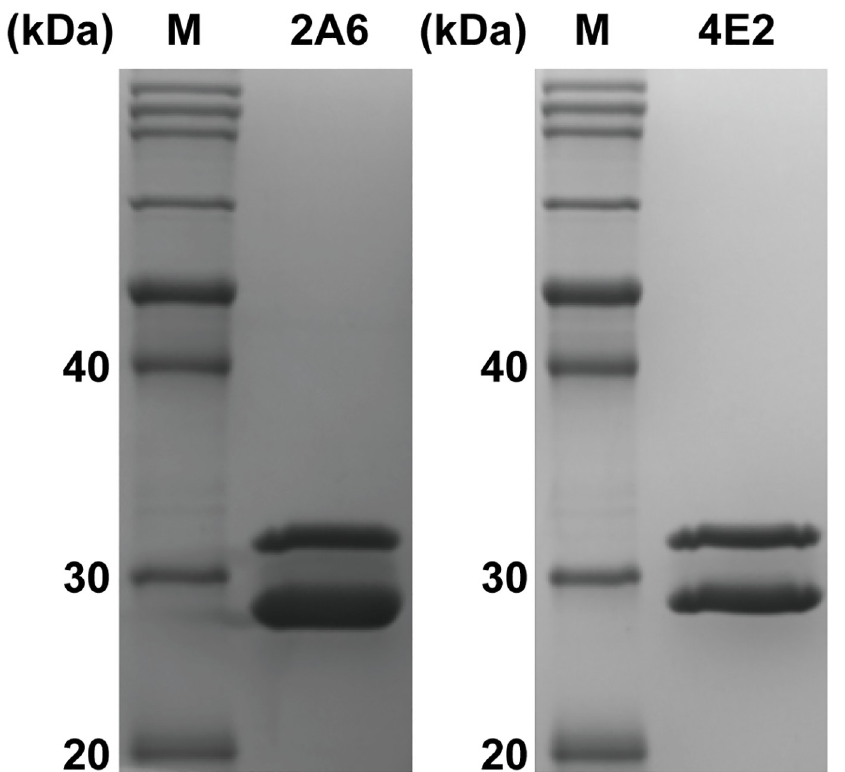
Fig 1. SDS-PAGE analysis of the purified Fabs. Purified Fabs 2A6 and 4E2 were preheated and then individually resolved by SDS-PAGE under denaturing and reducing conditions. The heterodimer was dissociated into the light chain (28 kDa) and the Fd fragment (32 kDa). Lane M represents the protein marker.